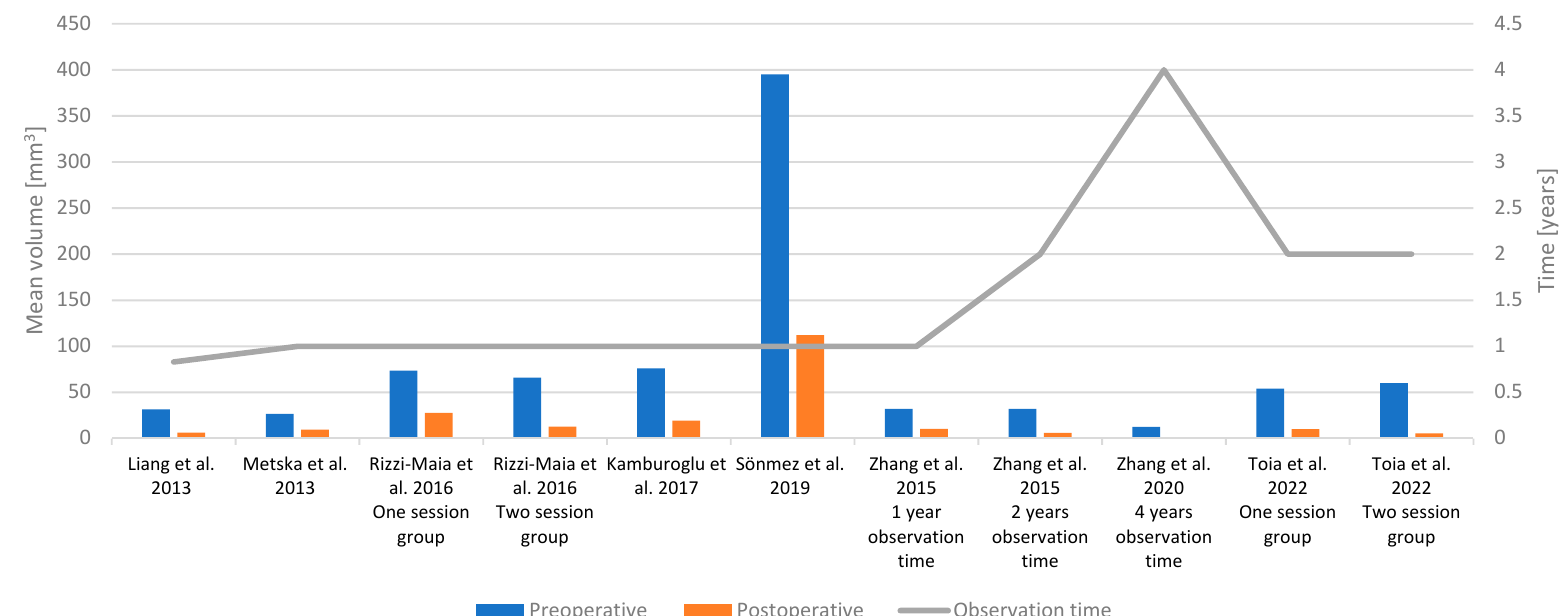
Figure 2. Postoperative decrease of the volume of apical changes in different observation times [10,11,12,20,21,16,14,56].